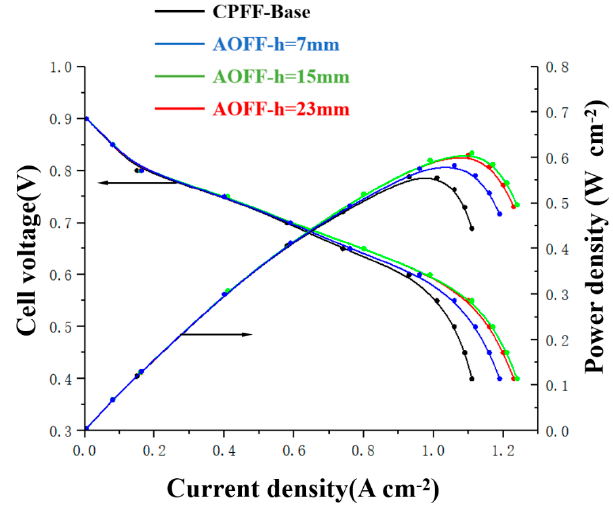
Figure 5. Performance comparison between the CPFF pattern and AOFF patterns: polarization curves and power density curves.